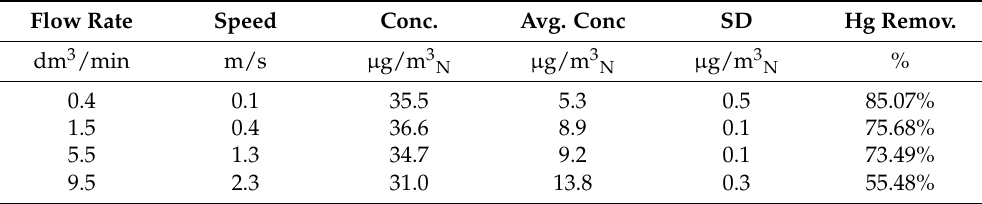
Table 7. The results of the determination of Hg in the flue gas after passing through the module (60 ◦ C).